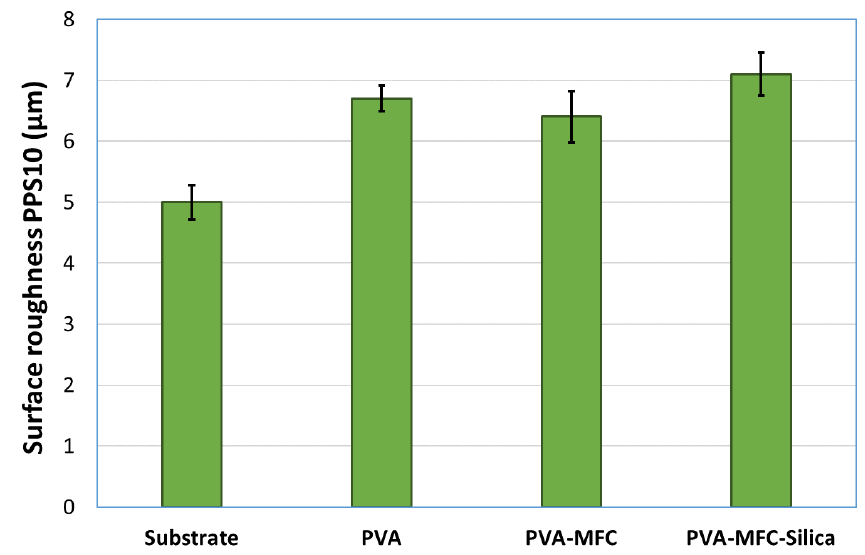
Figure 7. Surface roughness of the substrate and coated samples.